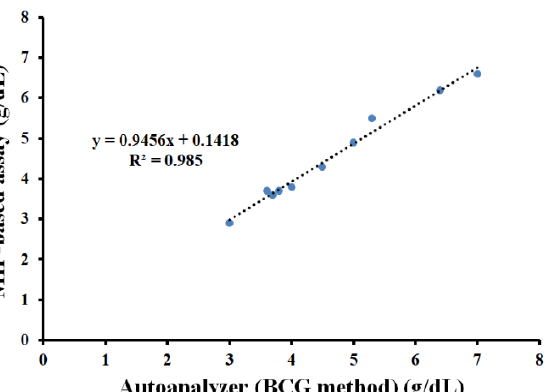
Figure 12. Comparison of HSA-MIP-based assay data (y-axis) to the BCG method (x-axis) of spiked artificial serum.